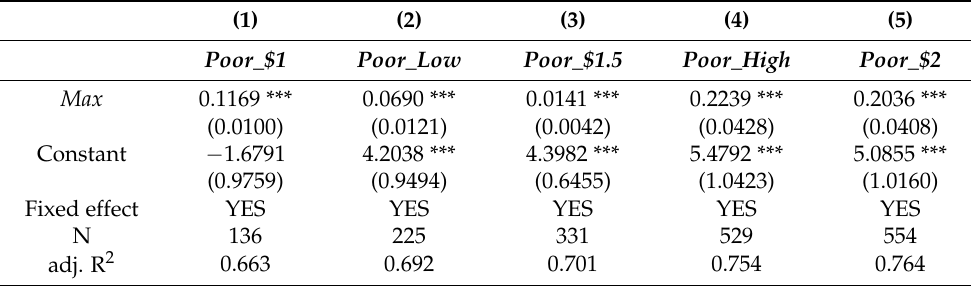
Table 7. Impact of extreme heat on groups with a probability of poverty greater than 0.29.